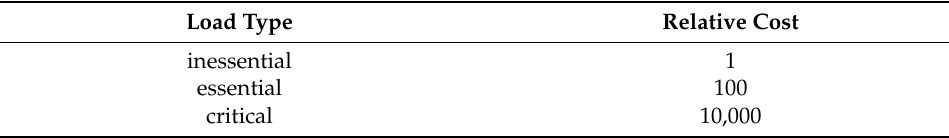
Table 6. Relative reliability cost.